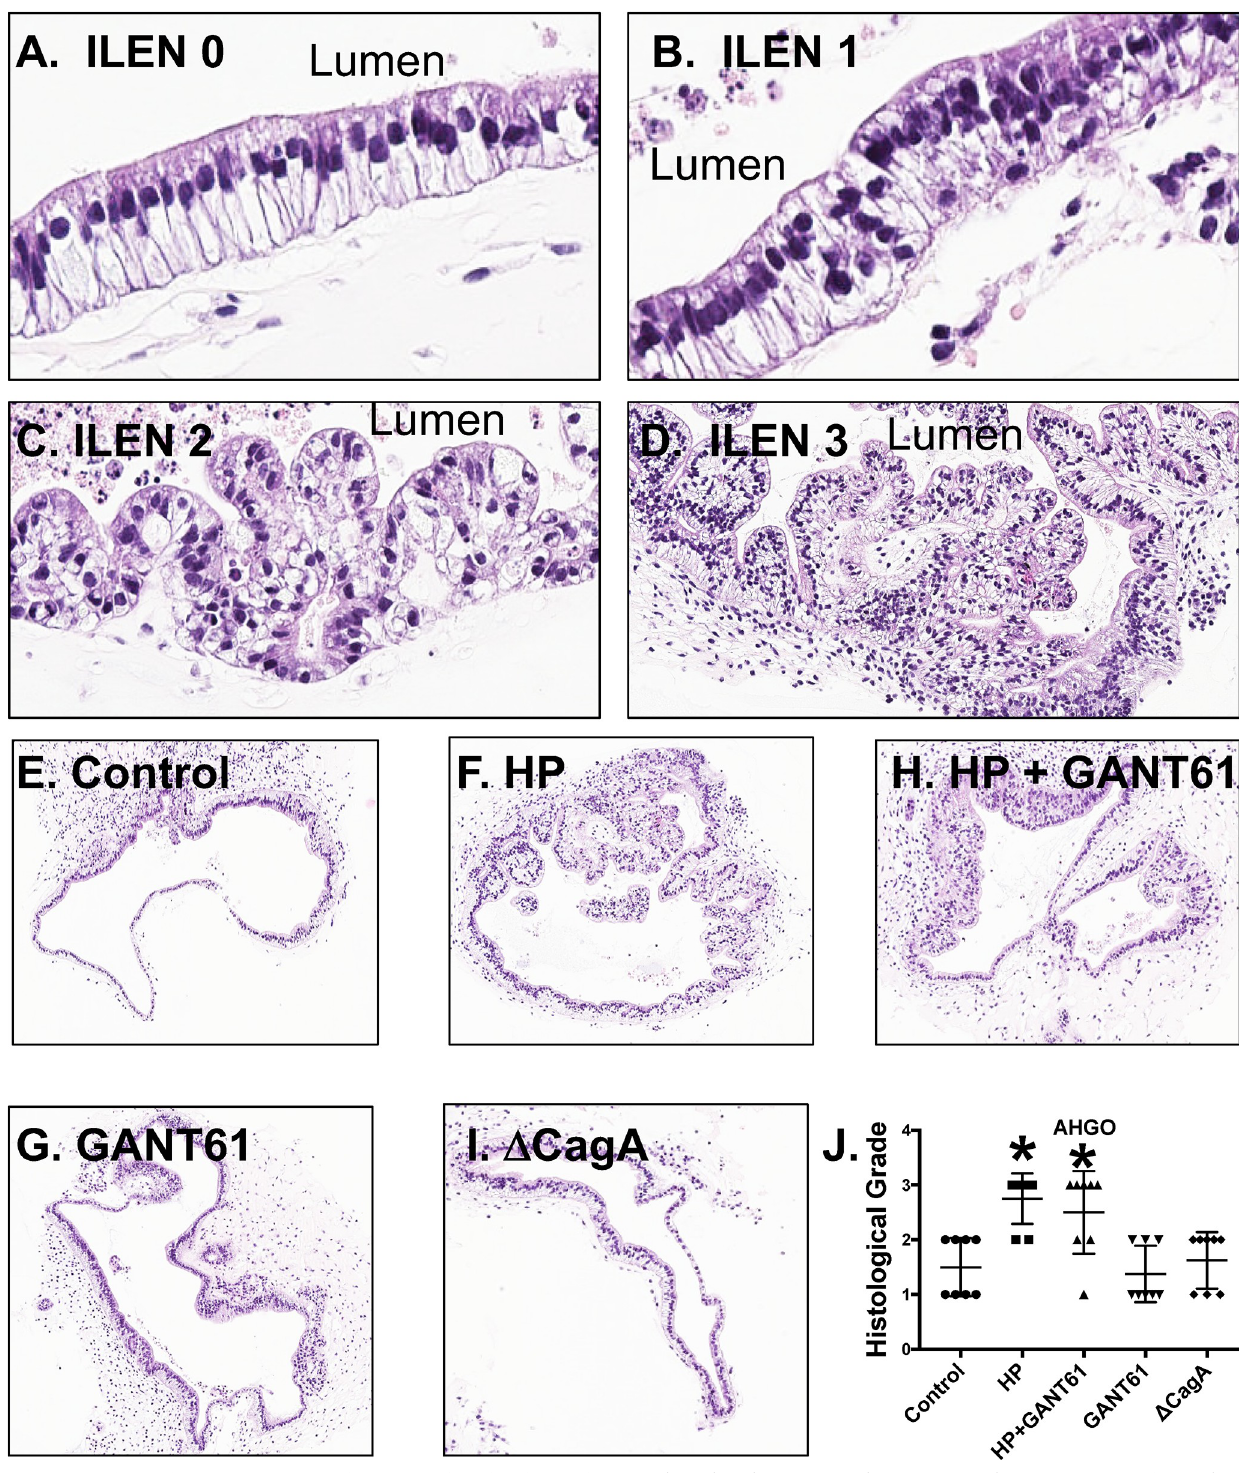
Fig 2. Metaplastic changes in FHGOs and AHGOs infected with H . pylori . Histological grade was assigned to experimental groups using I ntra l umenal E pithelial N eoplasia criteria of (A) 0, (B) 1, (C) 2 or (D) 3. H&E staining of organoids embedded from (E) control, (F) HP infected, (G) HP infected and GANT61, and (H) GANT61 treated, and (I) Δ CagA infected AHGOs. Histological grade assigned to each experimental group from (J) AHGOs. � P < 0.05 compared to control group by one-way ANOVA, n = 8 individual organoids.